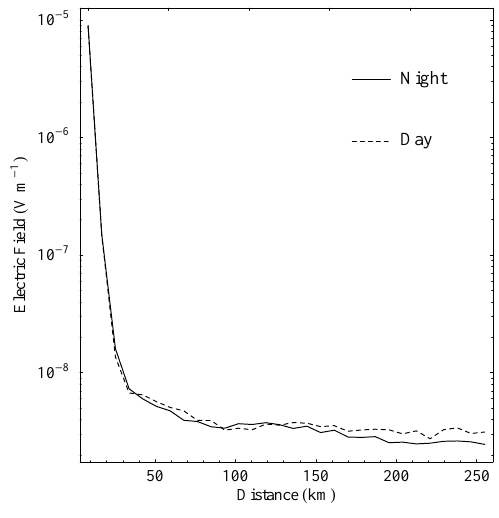
Fig. 4. The day and night electric field magnitudes at ground level, at a bearing of 40 ◦ from North, with increasing distance from